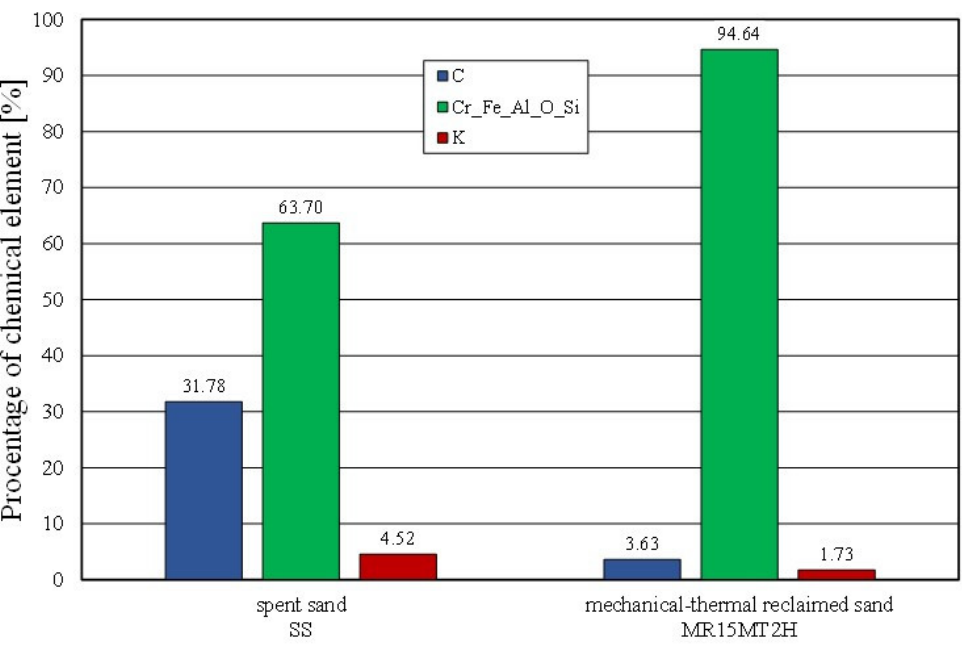
Figure 19. Comparison of chemical compositions of spent sand and grain matrix after mechanical– thermal reclamation.